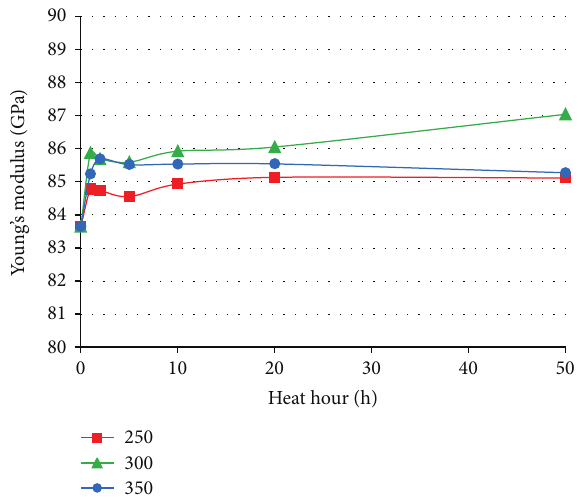
Figure 6: Young’s modulus obtained by ultrasonic measurement of longitudinal wave velocity and shear wave velocity for three heating temperatures: (a) 250 ∘ C, (b) 300 ∘ C, and (c) 350 ∘ C.